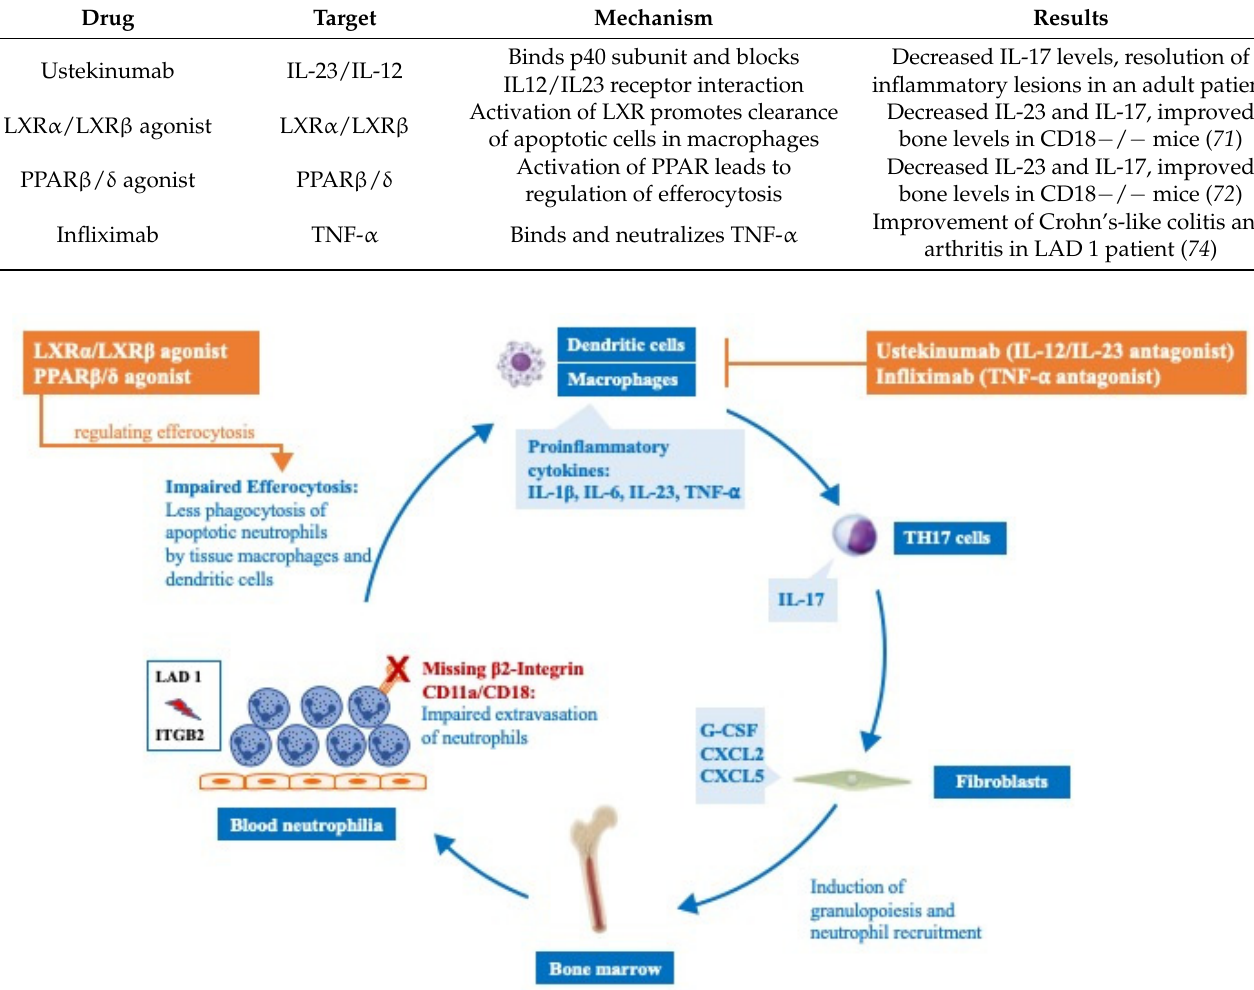
Figure 5. Inflammatory aspects of LAD I (adapted from Hajishengallis et al. [75]) Impaired migration of CD18-deficient neutrophils to the tissue leads to a disruption of neutrophil homeostasis in LAD I. This triggers the overproduction of IL-23 by macrophages and dendritic cells and downstream IL-17 produced by Th17-cells. IL-17 induces the production of G-CSF by fibroblasts, which results in excessive production and release of neutrophils from the bone marrow to the peripheral blood. The use of pharmacological inducers of neutrophil homeostasis regulators (LXR α /LXR β and PPAR β / δ ) and IL12/IL23 via Ustekinumab succeeded to cut off this inflammatory cascade. Table 1. Druggable targets in LAD-1.